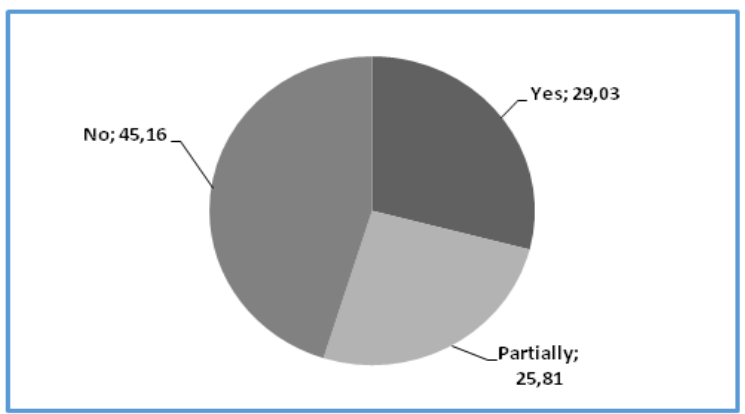
Fig. 5. Percentage of responses related to space and time